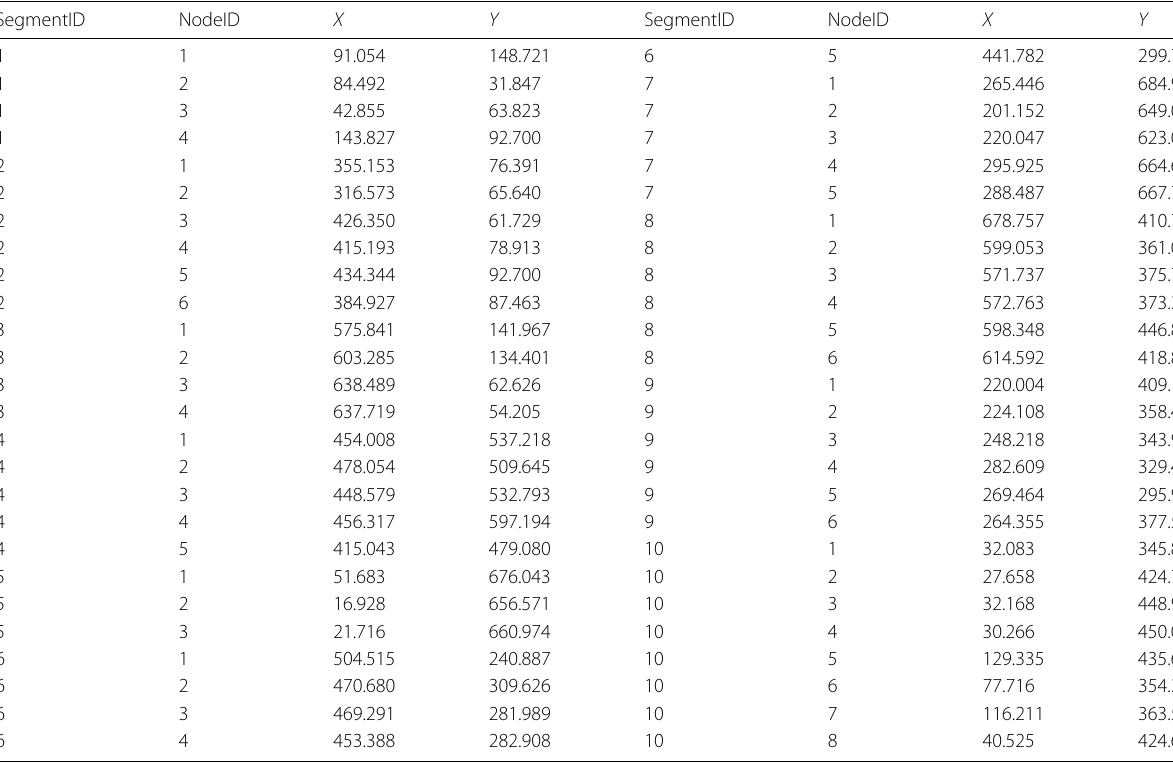
Table 3 X - and Y - coordinates of data in the file 10ch150.tsp